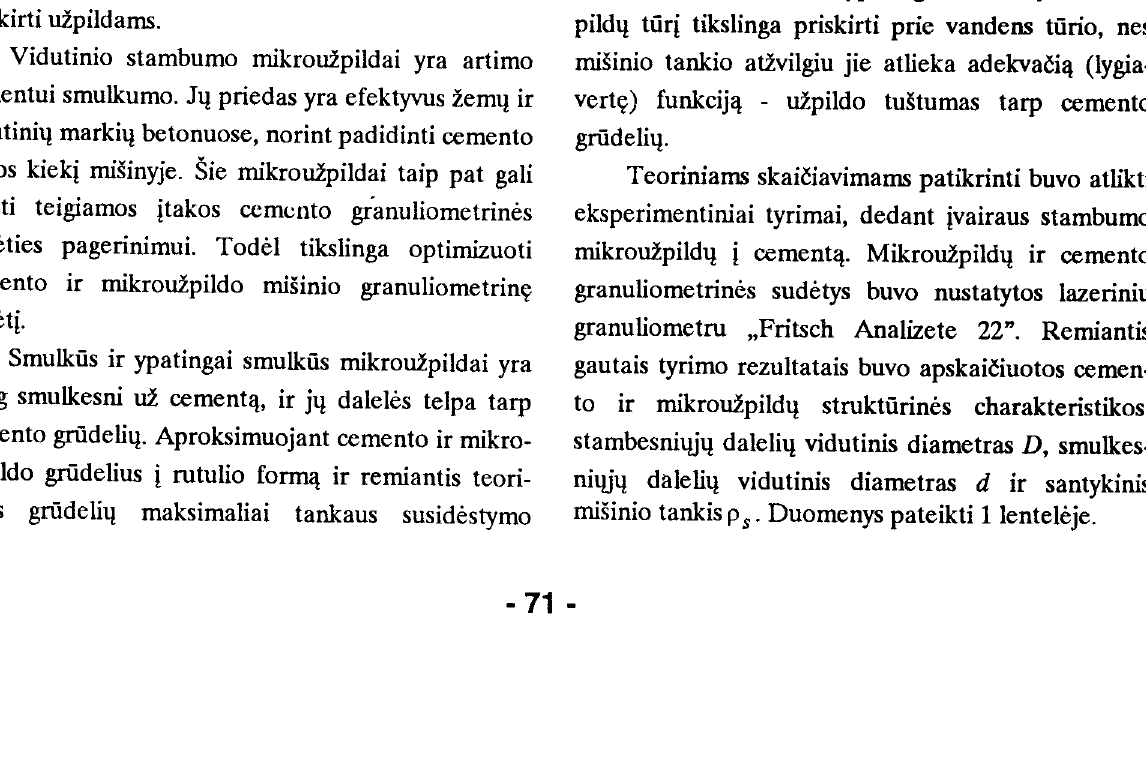
duose stokojama smulkiagriides frakcijos. Granu